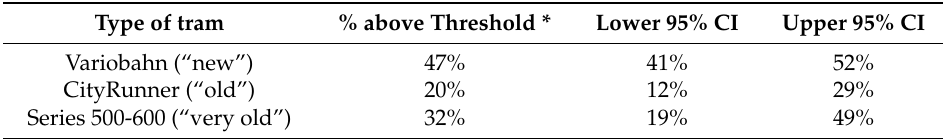
Table A2. Maximum Sound Levels indoors during passing by tram